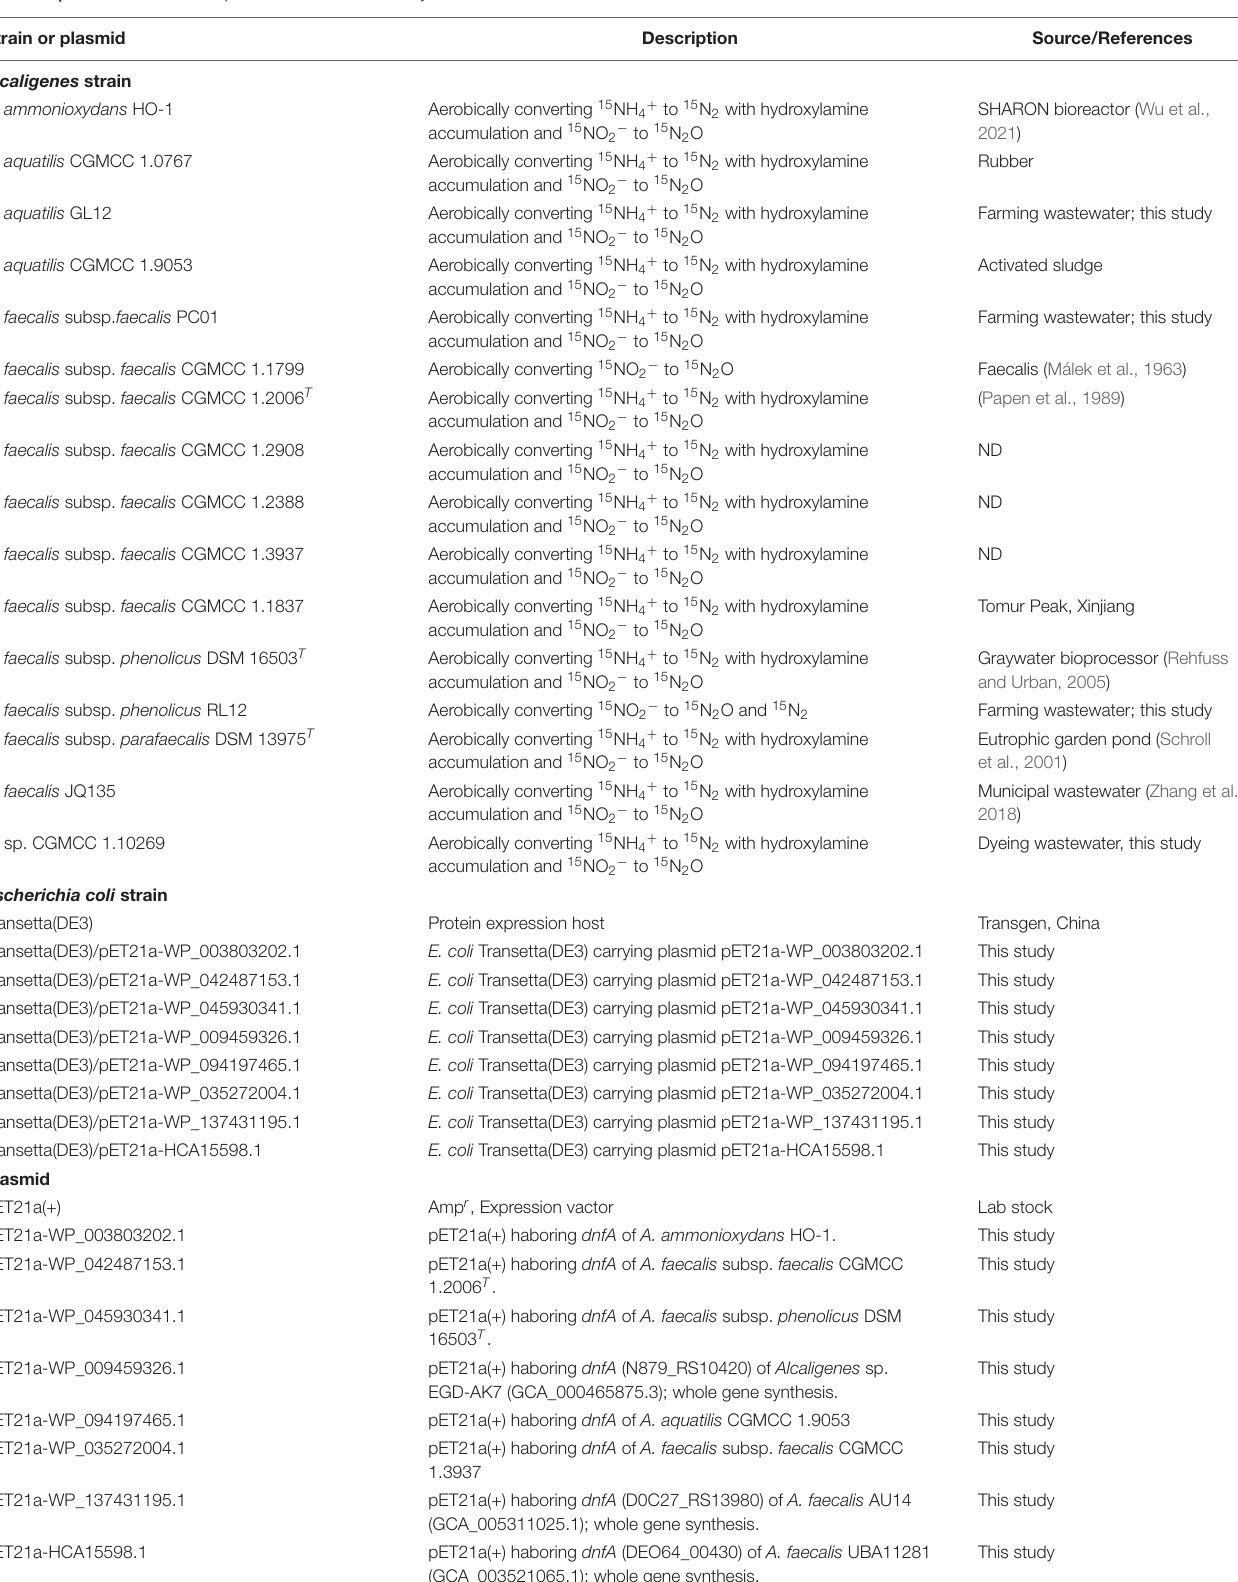
TABLE 1 | Bacterial strains and plasmids used in this